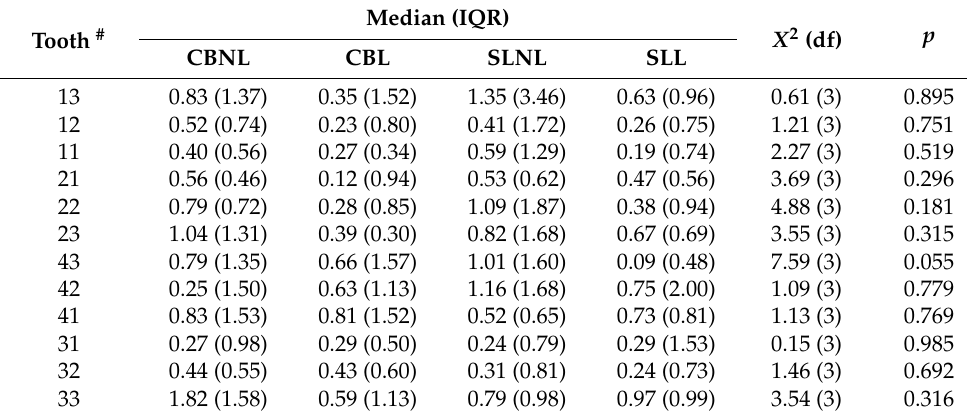
Table 7. Root resorption among all